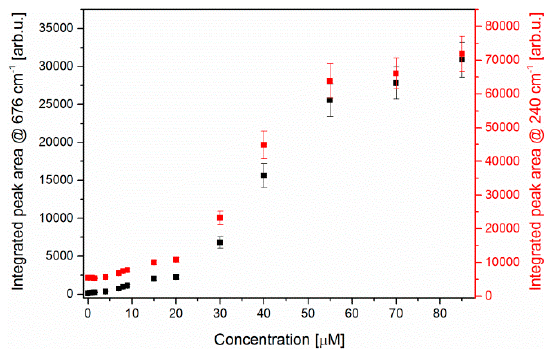
Figure 3. Integrated peak area of the PYO Raman mode at 676 cm − 1 (black) and of the mode at 240 cm − 1 which corresponds to the Ag-(adsorbed atom) (red).